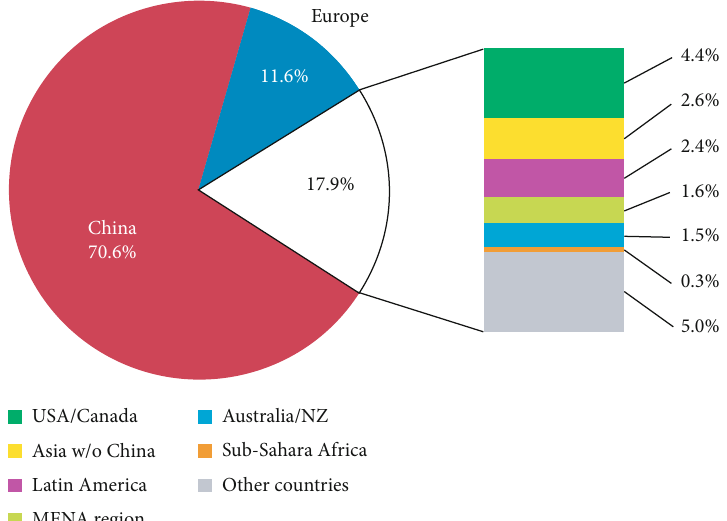
Figure 3: Share of the total installed capacity in operation (glazed and unglazed water and air collectors) by the economic region in 2014 [20,